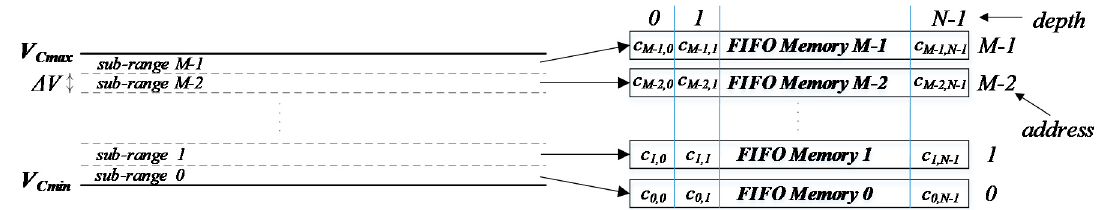
Figure 4. The operating voltage range of each capacitor is divided in sub-ranges with a resolution ∆ V . Each sub-range is mapped in a FIFO memory, where only the Sub-Module (SM) positions are stored. Firstly, a position number P i is assigned for each SM based on its physical placement in the arm.